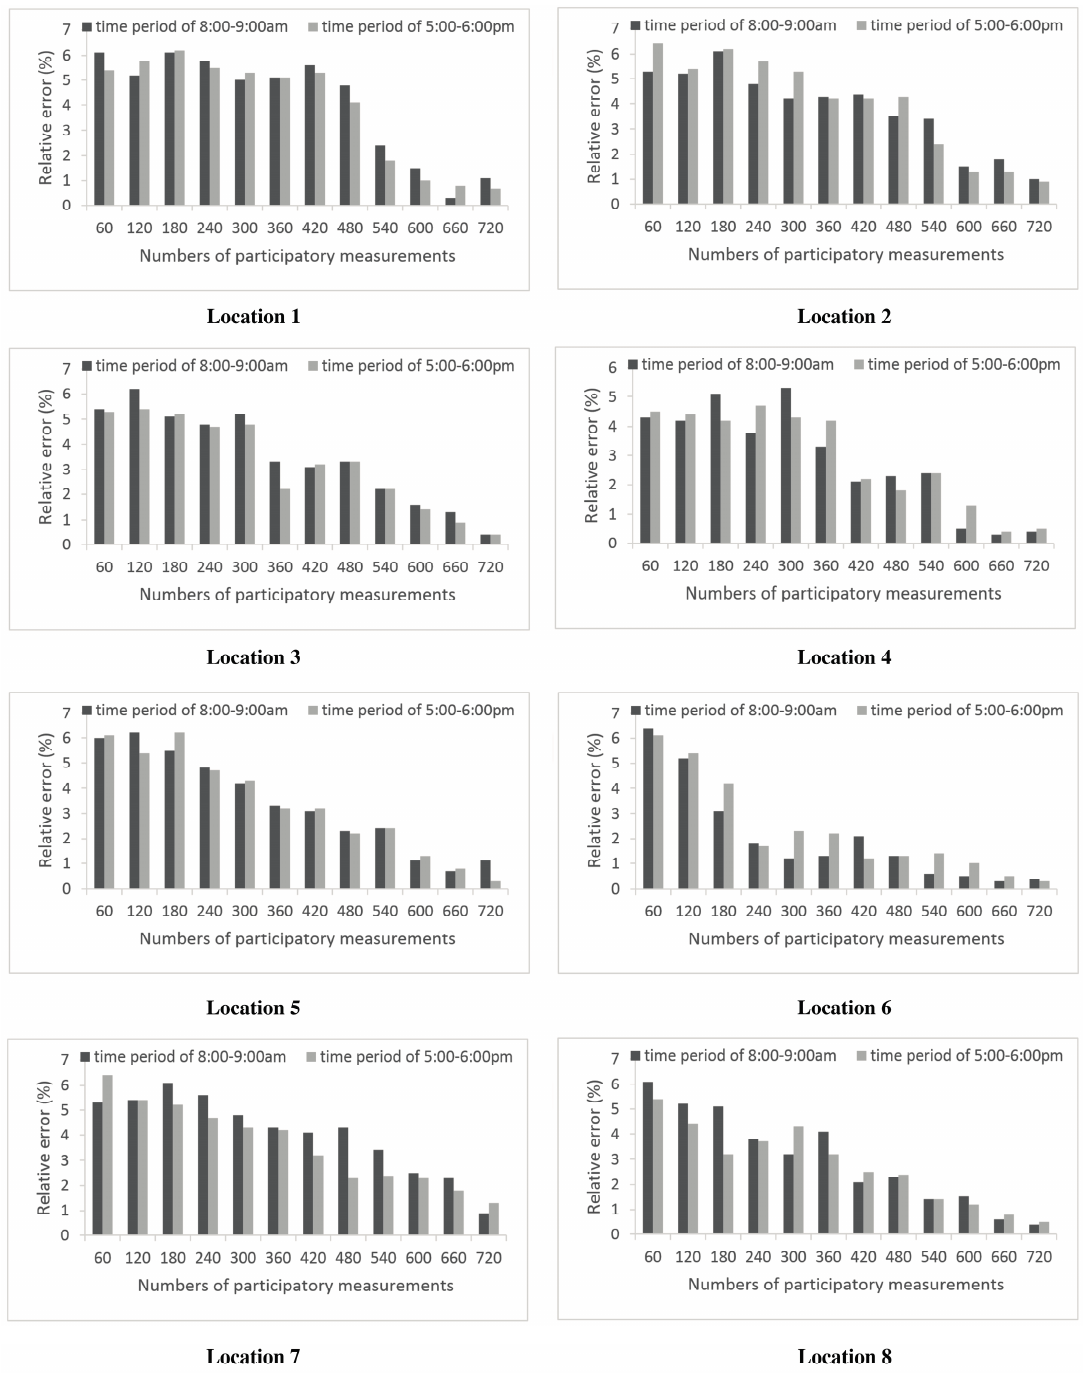
Figure 7. Comparison between the measured and estimated noise levels for each virtual partition at eight fixed